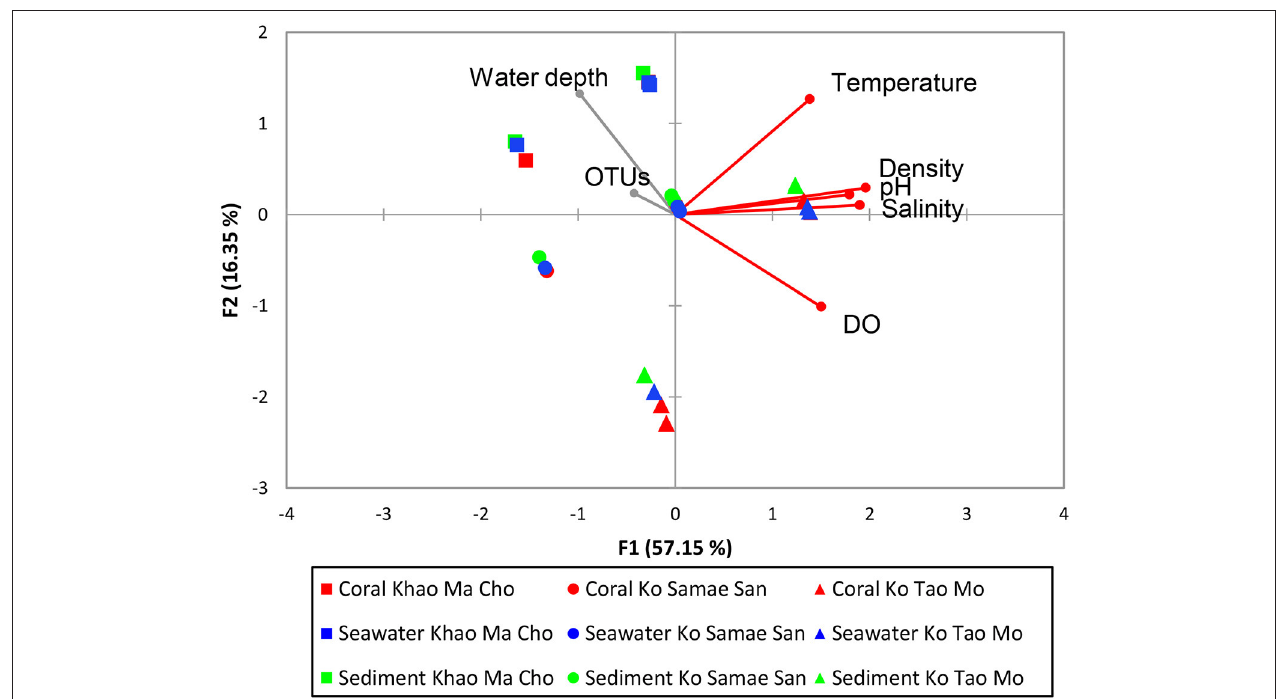
FIGURE 5 | Pearson’s correlation of water physical variables on prokaryotic community structures. The vector direction and length represents the direction and strength of that variable factor. The vector color red represents significant correlation ( p < 0.01), and gray represents non-significant correlation ( p ≥ 0.01). Pearson’s correlation of water physical properties on the merged subgroups with p > 0.01 are identical in results and thus not